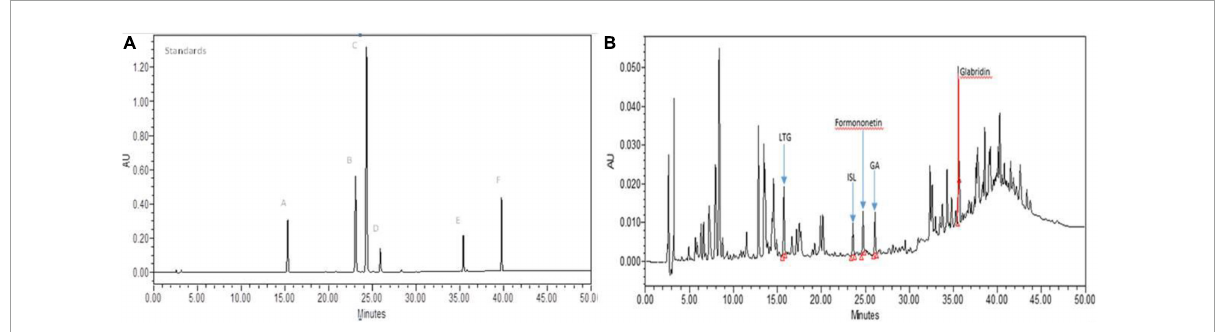
FIGURE1 (A) Representative HPLC chromatogram of the standard mix (1.0 mg/ml) of (A) Liquiritigenin (LTG), (B) Isoliquiritigenin (ISL), (C) Formononetin, (D) Glycyrrhizic acid (GA), (E) Glabridin (GLB), and (F) Glycyrrhetinic acid (GTA) at 254 nm. (B) HPLC chromatogram of Ethanolic extract of Glycyrrhiza glabra (GgEtOH) at 254 nm. LTG—0.65%, ISL—0.17%, GA—0.69%, GLB—1.65%, F—0.12%.